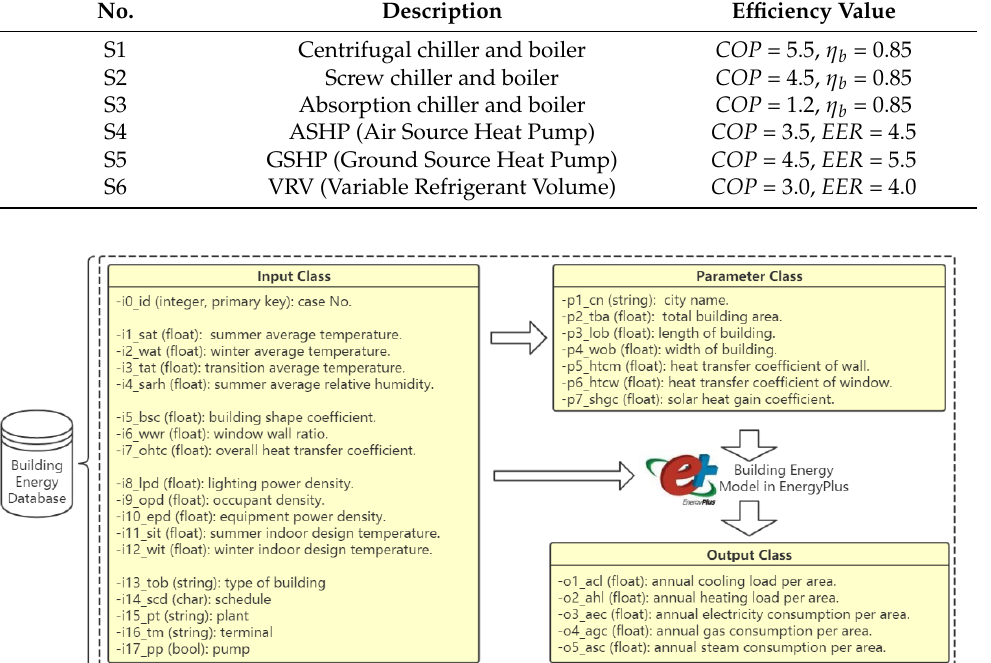
Figure A1. Various possible subsystems of the total HVAC system in the model database.